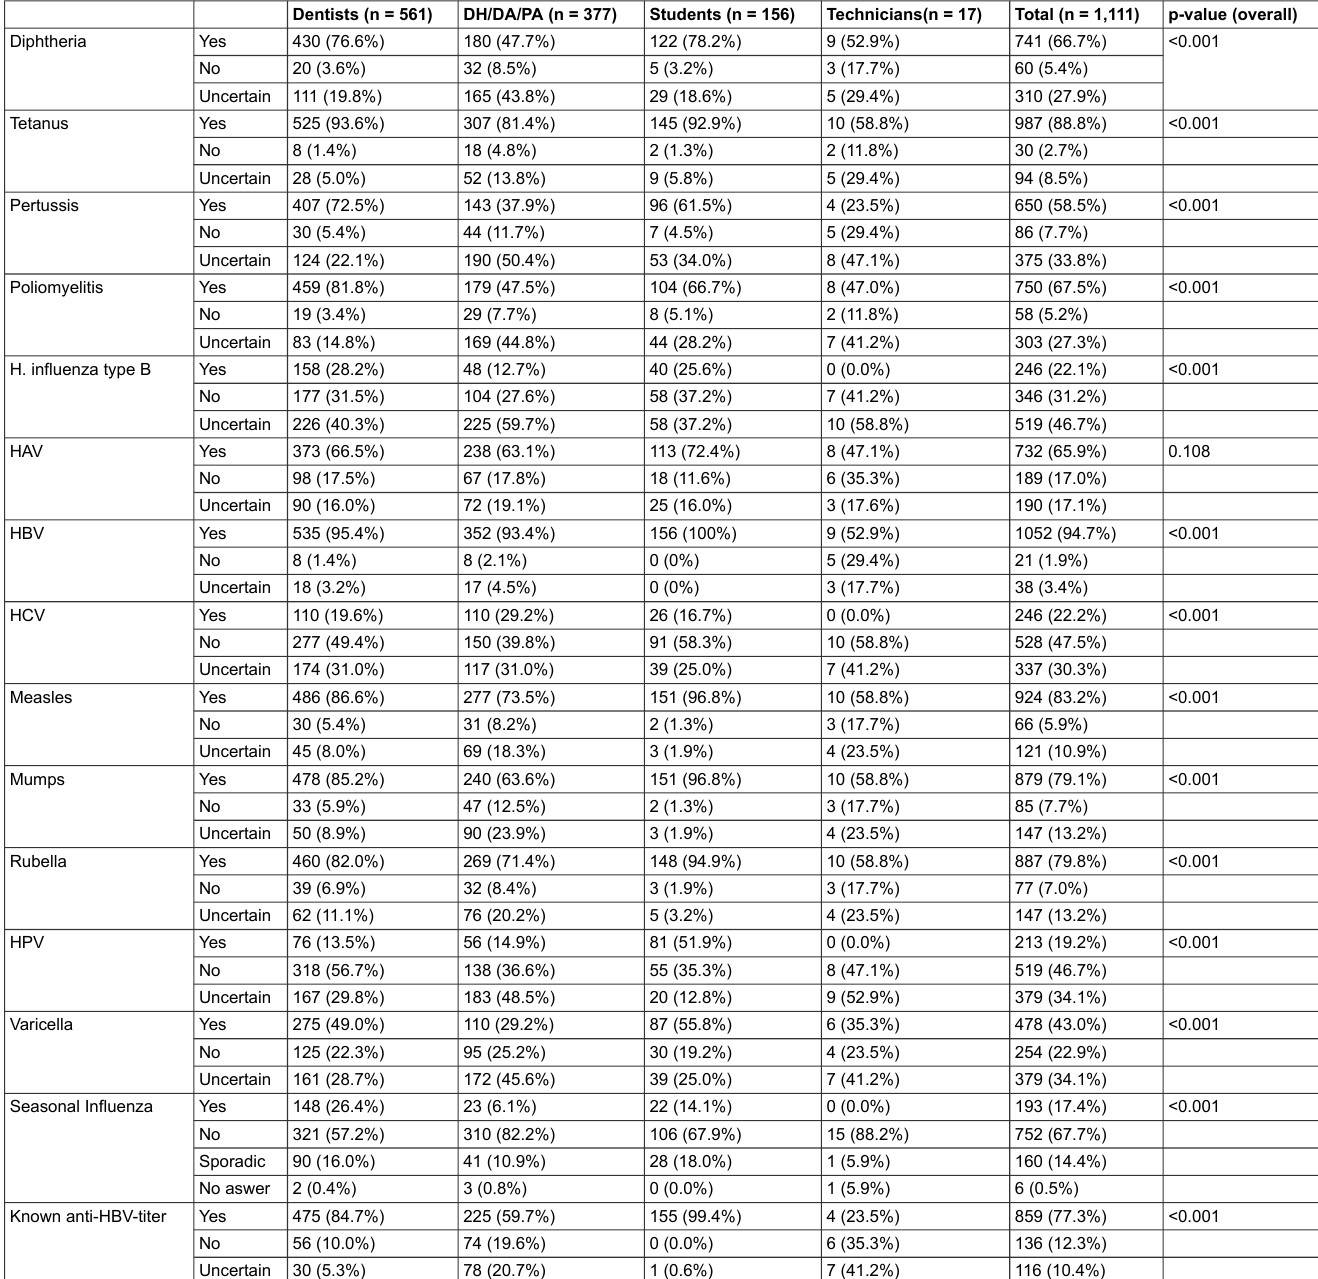
Table 3: Immunisation status, by vaccination or by immunity after disease, of the